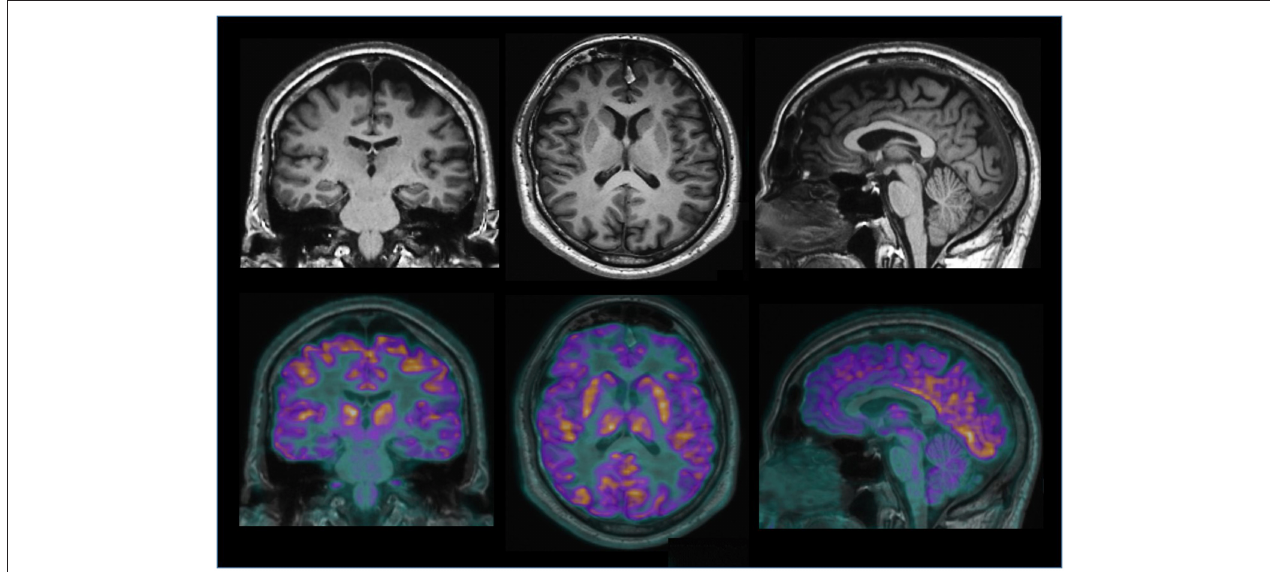
FIGURE 2 | Hybrid brain PET/MRI imaging (Biograph mMR, Siemens) in a normal subject. The top picture shows anatomical MRI 3D T1-weighted images on the coronal, axial and sagittal slices. In the figure above, a metabolic 18FDG PET image of the same individual is combined with the MRI image to obtain information on the morphology, anatomy and metabolism of the brain.